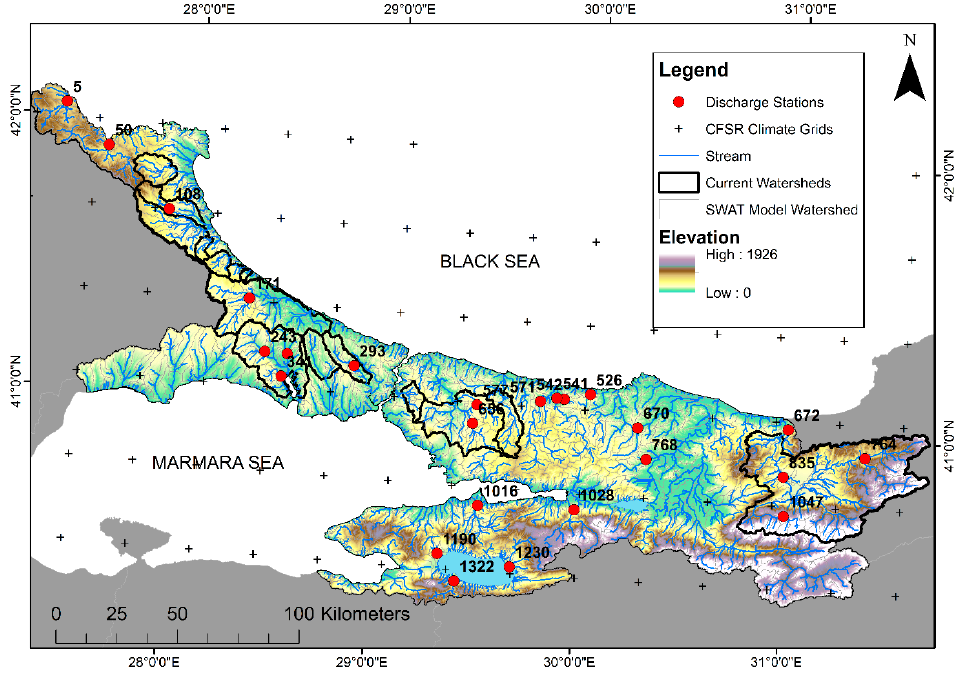
Figure 4. Location of the water resources of Istanbul, topography, rivers, climate grids and discharge stations used in the model.